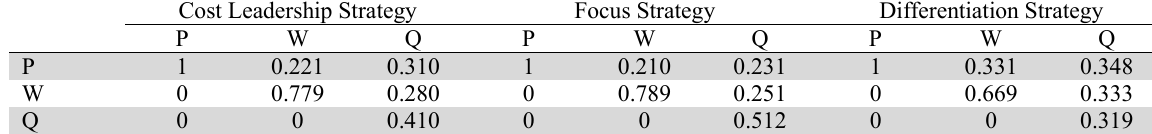
Degree of relative impact for factors in different strategies. Cost Leadership Strategy Focus Strategy Differentiation Strategy